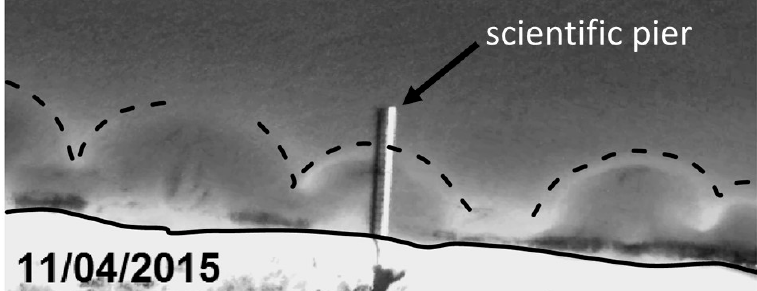
Figure 1. Satellite image of the crescent underwater bars at the Shkorpilovtsy study site (Image © 2017 Digital Globe). Dotted line: the crest of the bar; solid: the water’s edge.